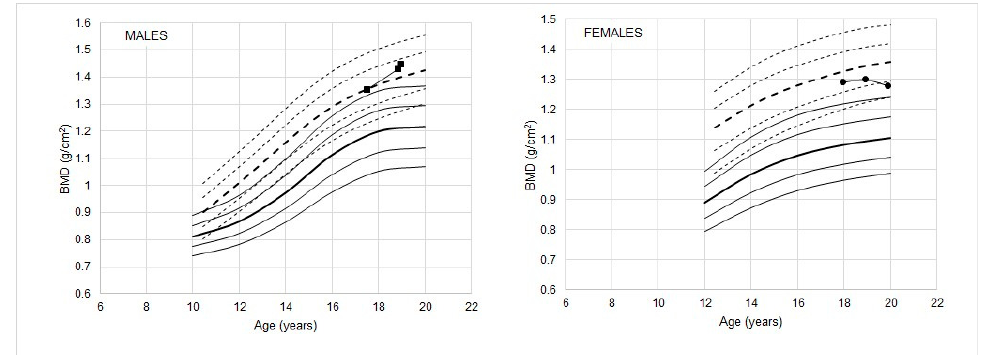
Figure 4. BMD of two athletes, a female handball player and a male football player, is shown relative to the percentiles (- - -) for athletes and the DEXA reference (—) percentiles (10th, 25th, 50th, 75th, 90th; the 50th percentiles are in bold).